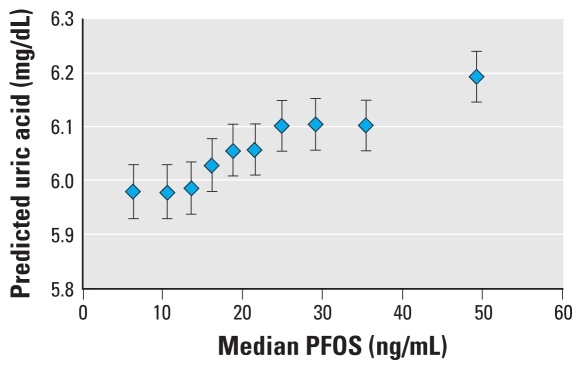
Predicted uric acid with increasing PFOS. Predicted value from regression model for an average participant: 45 years of age, 0.95 mg/dL creatinine, high school education, male, 28.55 kg/m2 BMI, nonsmoker, nondrinker. Data are population means and 95% CIs.